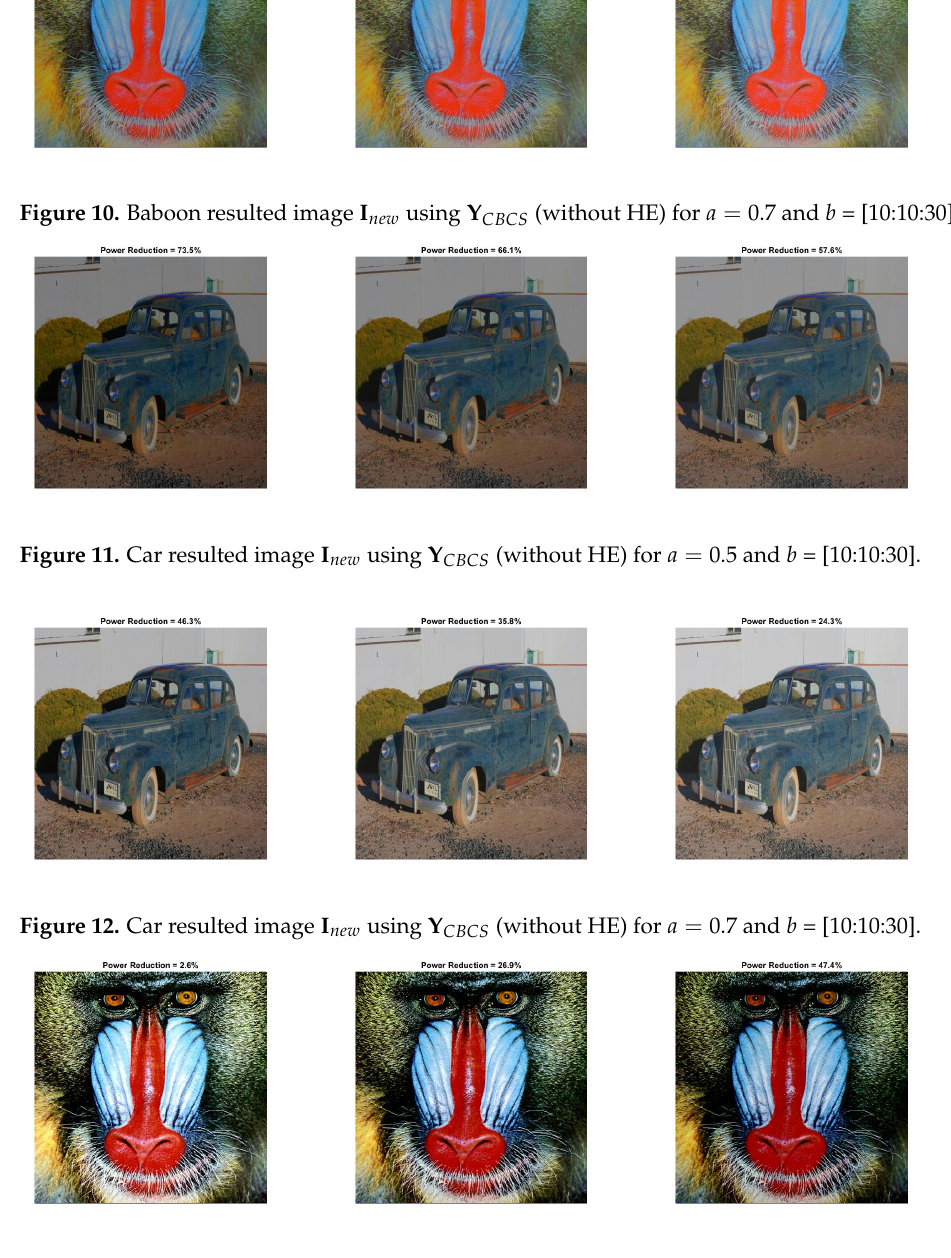
Figure 13. Baboon resulted image I new using Y CBCS (with HE) for a = 1 and b = [10:10:30].